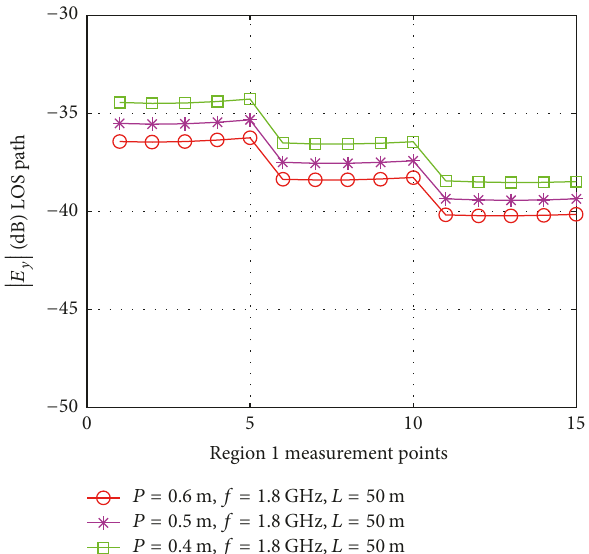
Figure 5: The distribution of 𝐸 𝑦 for different period of slots of horizontally polarized LCX in Region 1 for LOS path.